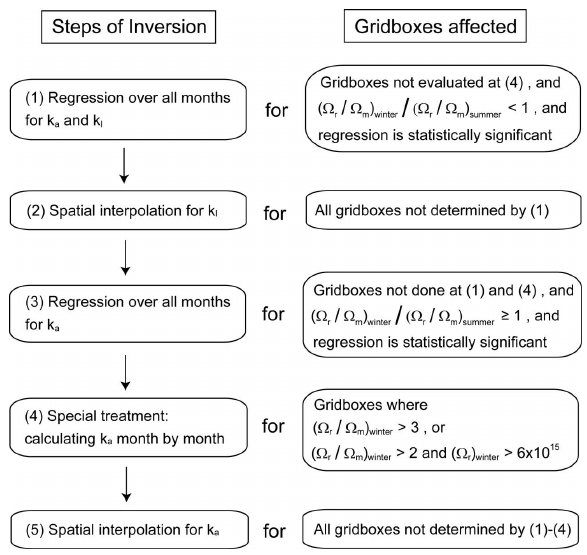
Fig. 6. Description of the regression-based step-by-step inversion 3 process after gridbox grouping. Values of k l are determined at steps 1 and 2 for all gridboxes and k a at steps 1, 3, 4, 5. See Sect. 4.1.2 for detailed